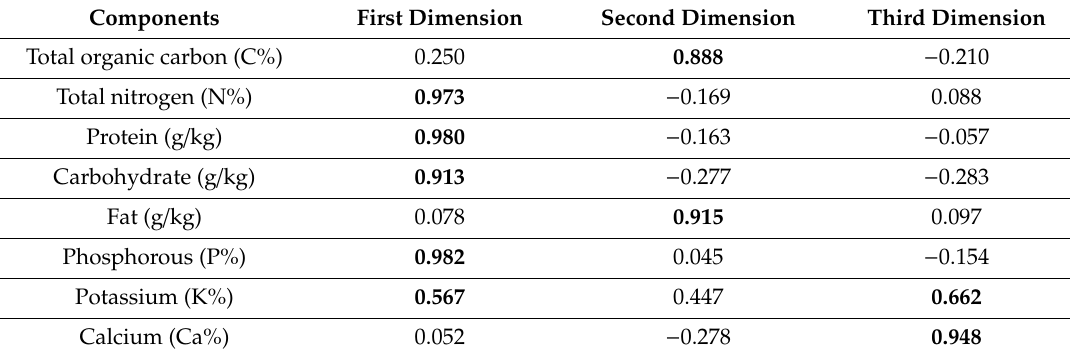
Table 2. Results of the principal component analysis and correlation coefficients by variables and dimensions, characterising the compositions of the rearing substrates.